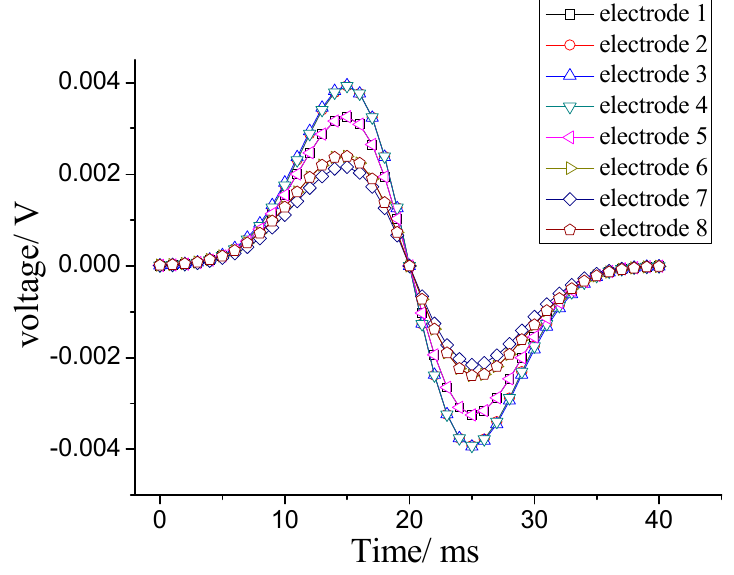
Figure 6. Eight output signals of the ESA.